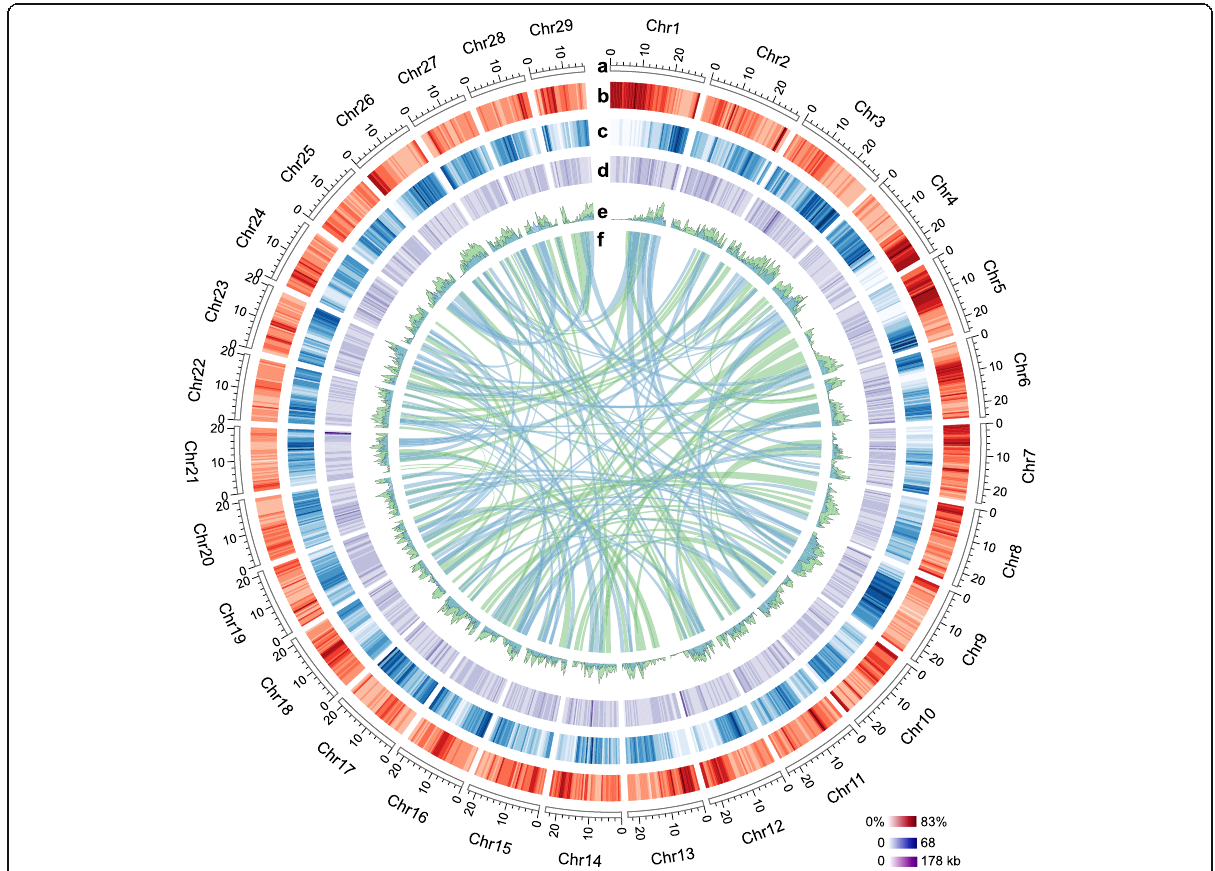
Fig. 1 A high-quality genome assembly of Actinidia eriantha (Ae). a Circular representation of the chromosome-scale pseudomolecules. b The percentage of transposable-element coverage in sliding windows of 0.5 Mb. c Gene density in sliding windows of 0.5 Mb. d Length distribution of the presence/absence-variation (PAV) genes between Ae and Actinidia chinensis (Ac). e Genes evolved in relation to the respective Ad- α (light green) and Ad- β (light blue) whole-genome duplication (WGD) events. f The syntenic regions (only >N50 size shown here) involved into the Ad- α (light green) and Ad- β (light blue) WGDs,